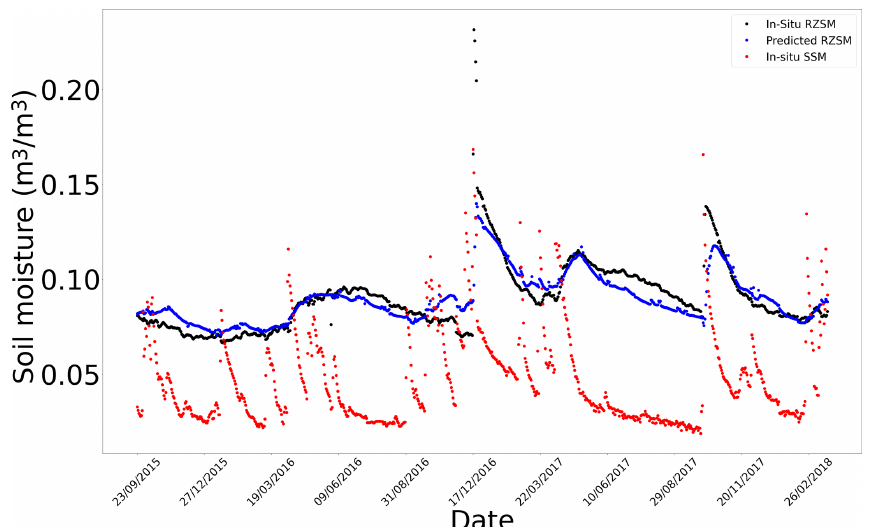
Figure G8. In situ SSM, in situ RZSM, and predicted RZSM series at station Hmidate_163 (Tunisia) with model ANN_SSM_NDVI_EVAP-